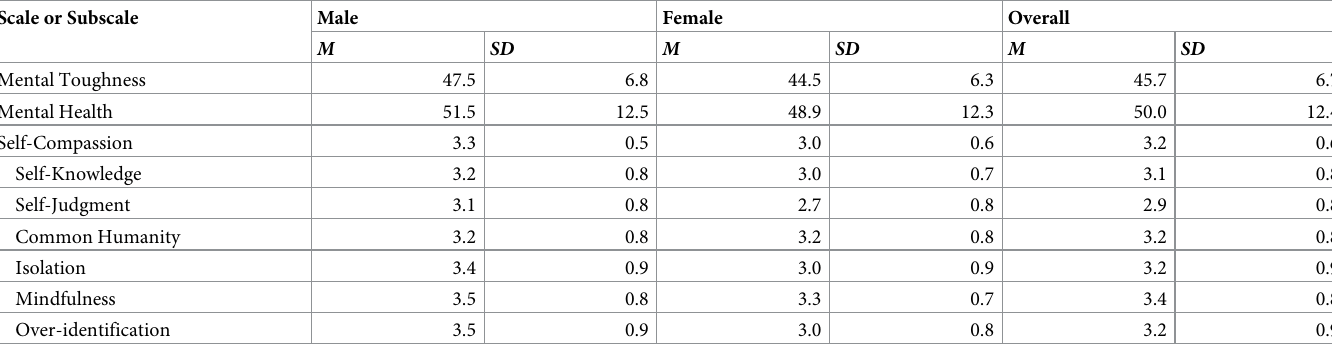
Table 2. Descriptive statistics of all scales and subscales by gender.